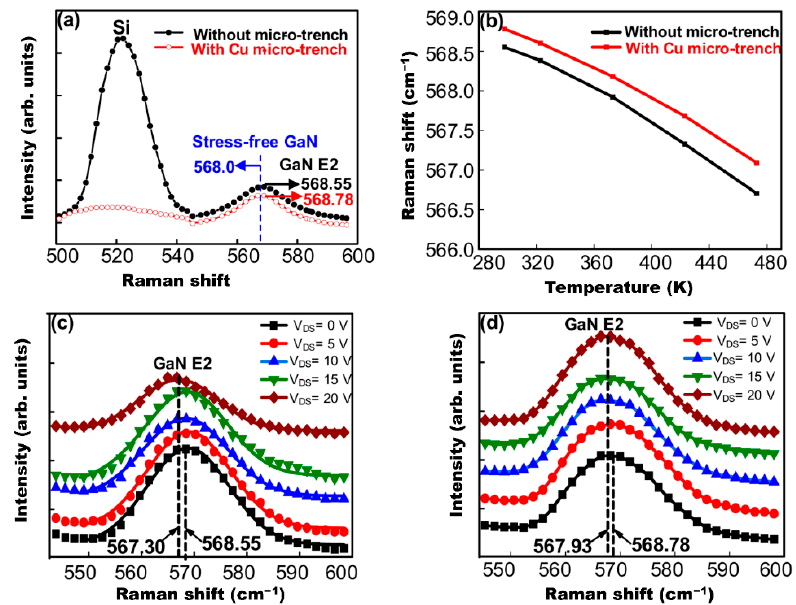
Figure 11. Validation of temperature rise in a device structure with Raman thermometry: ( a ) peak frequency of GaN and Si E2, ( b ) dependence on temperature of the active E2 mode in GaN, ( c ) peak E2 shift of GaN without micro-trench fabrication, and ( d ) peak E2 shift using a Cu-filled micro-trench, which is lower than without the micro-trench. Based on the channel temperature at various drain-source biases (V ds ) in the Cu-deposited trench structure, the shift of the E2 (high) peak is reduced, suggesting effective heat removal. Reprinted under terms of the CC-BY license [162]. Copyright